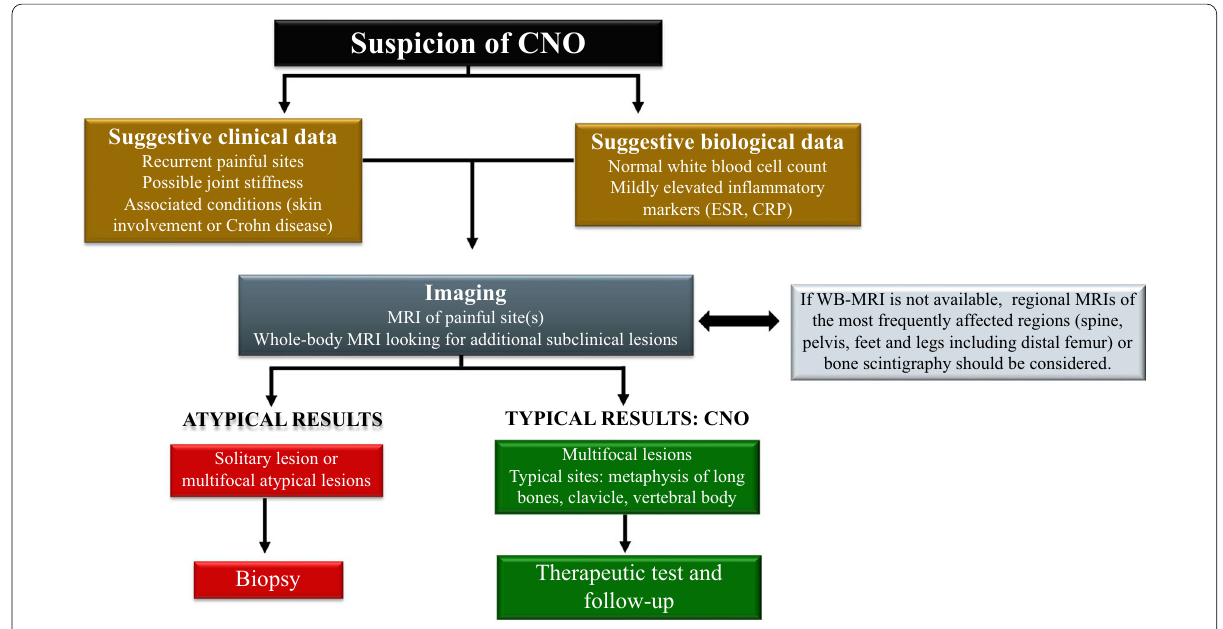
Fig. 5 Diagnostic approach. Adapted from Falip et al.